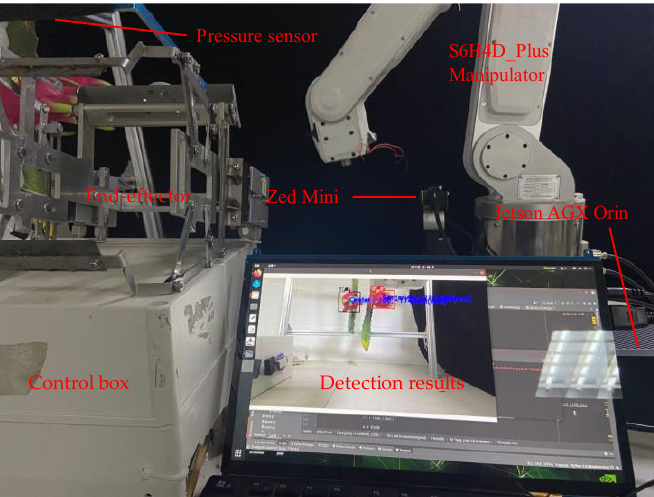
Figure 10. The dragon fruit picking